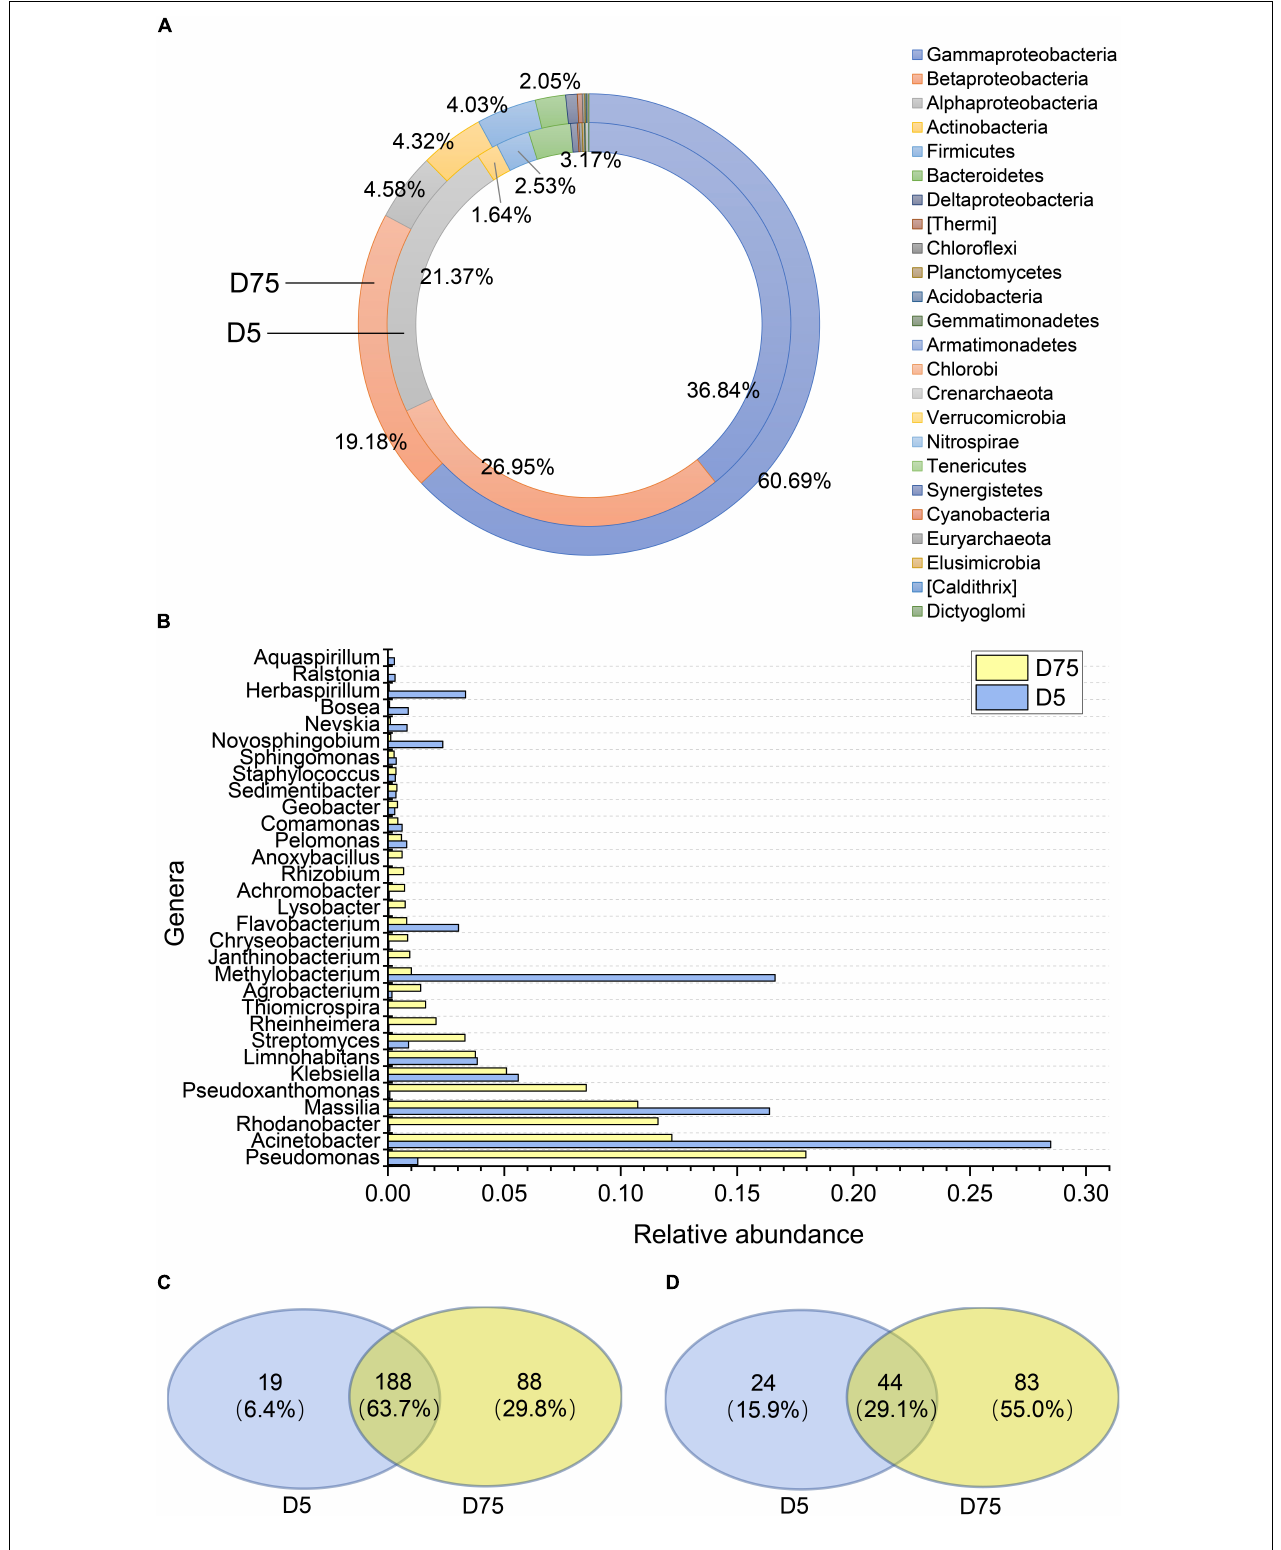
FIGURE 2 | Composition of sorted transconjugant pools on day 5 and day 75. (A) Phylum distribution. (B) The relative abundance of the top 20 genera on day 5 or day 75. (C) Venn diagram showing the number of shared and unique genera between D5 and D75. (D) Venn diagram showing the number of shared and unique core OTUs that contributed 95% sequences among D5 and D75